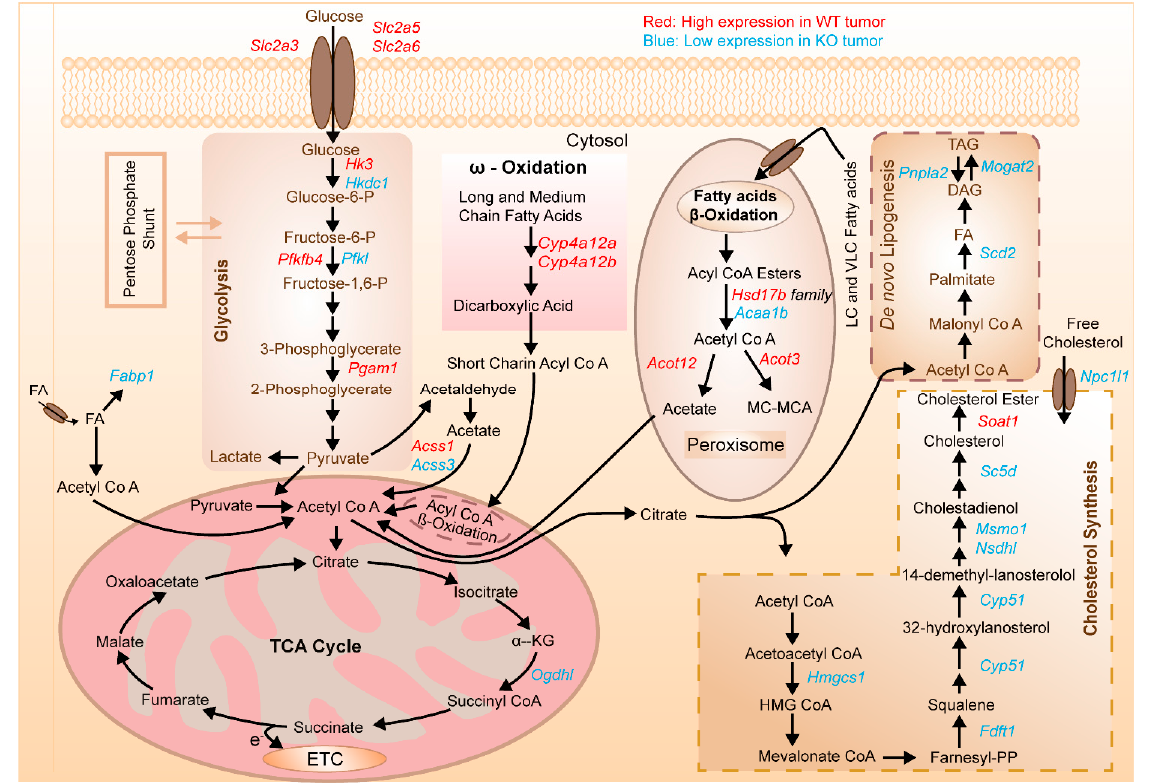
Figure 7. Schematic representation of the deregulated genes involved in different metabolic pathways in hormonally induced HCC. Enriched genes mentioned in each pathway are selected from heatmap (Figure 6A). Shown in red are the transcripts that displayed upregulated expression in tumors formed in wild type mice, while blue indicates downregulated genes in knockout tumor.